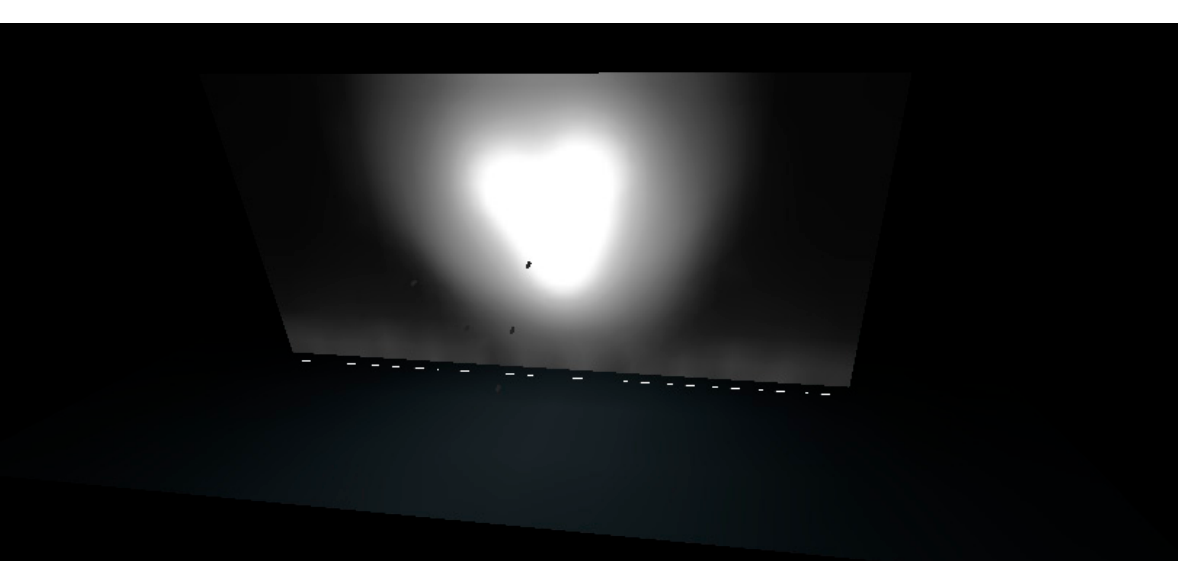
Figure 13. Working Diagram II depicting the concept of “love” with different lighting patterns.